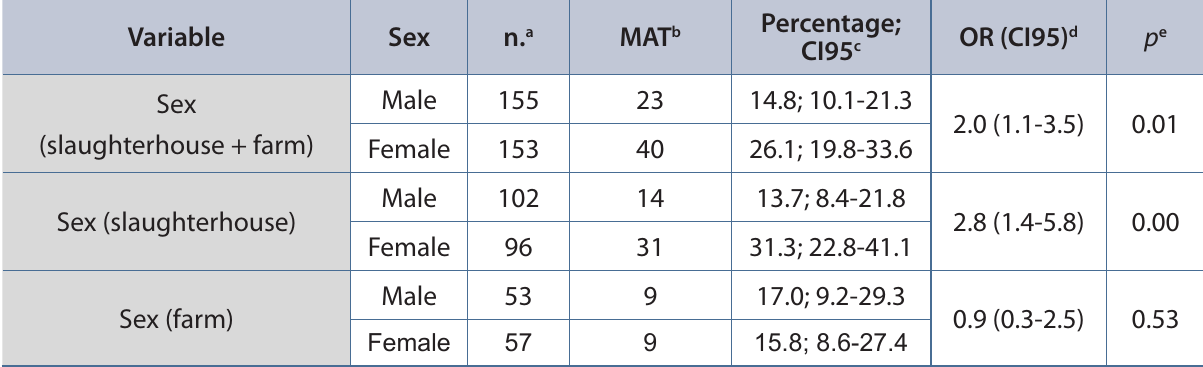
Table 2. Statistical results for the studied places concerning the sex of the animals